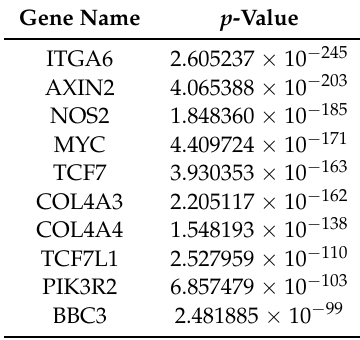
Table 1. Classical approach. ten genes with the higher impact between conditions.